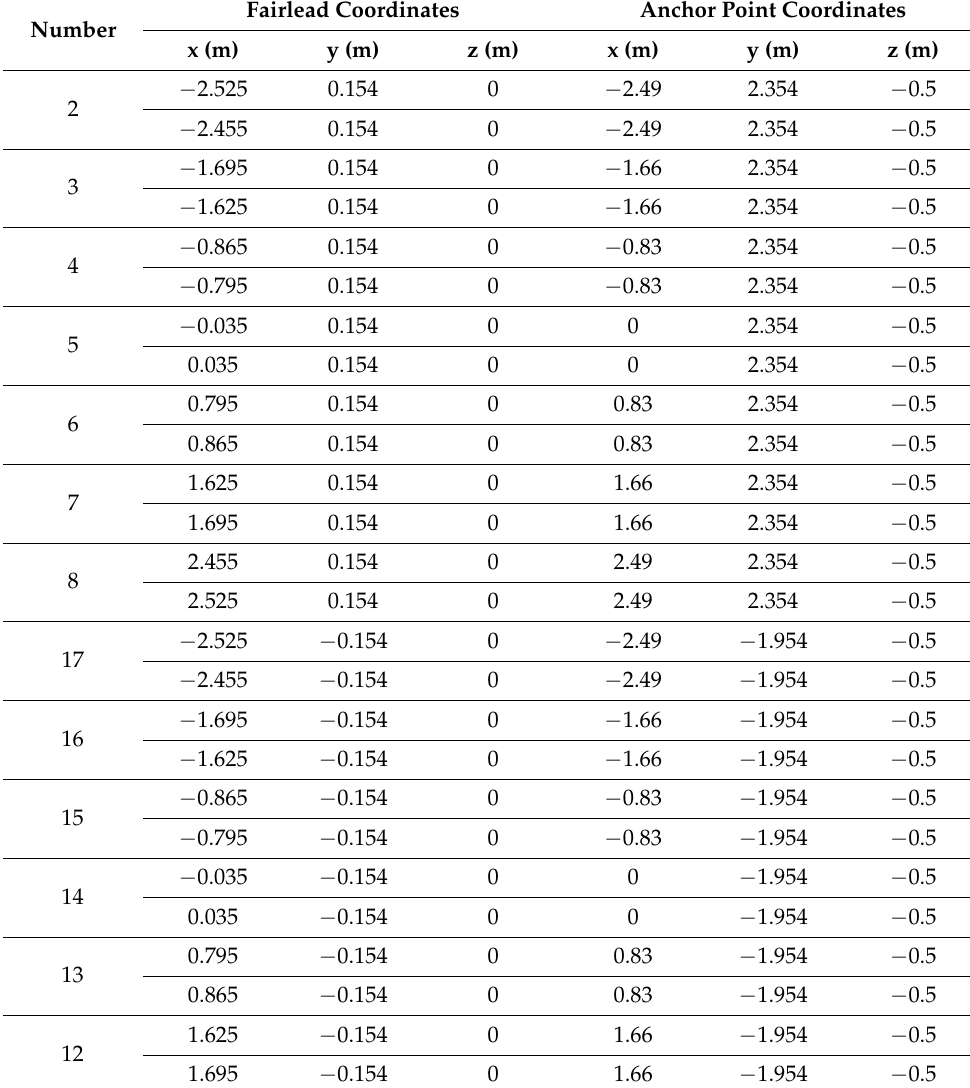
Table 3. Mooring line parameters of geometric properties.